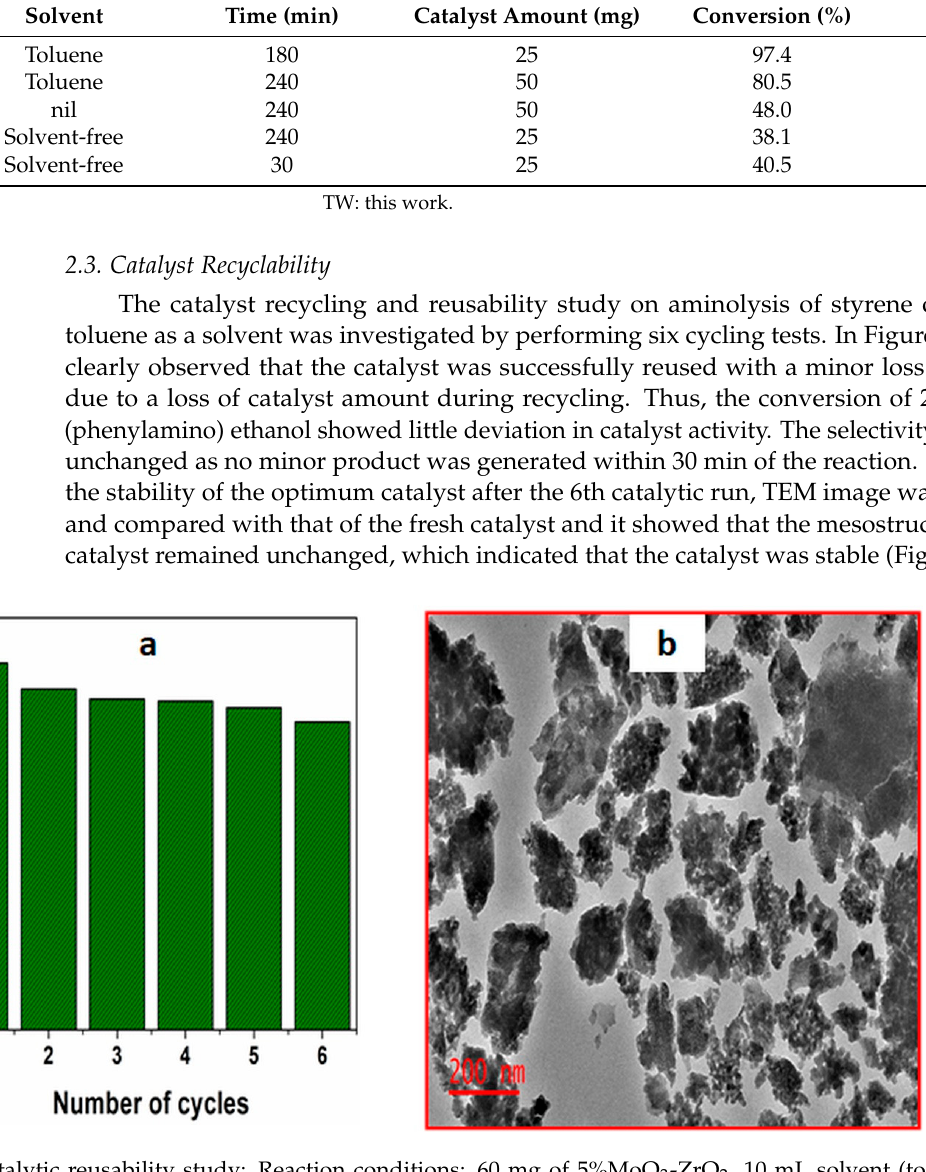
Figure 4. ( a ) The catalytic reusability study: Reaction conditions: 60 mg of 5%MoO 3 -ZrO 2 , 10 mL solvent (toluene), temperature = 120 °C, decane = 0.237 mmol, aniline = 4.20 mmol and styrene oxide = 3.50 mmol. ( b ) TEM image taken after the 6th catalytic cycle to confirm the stability of the optimum catalyst.